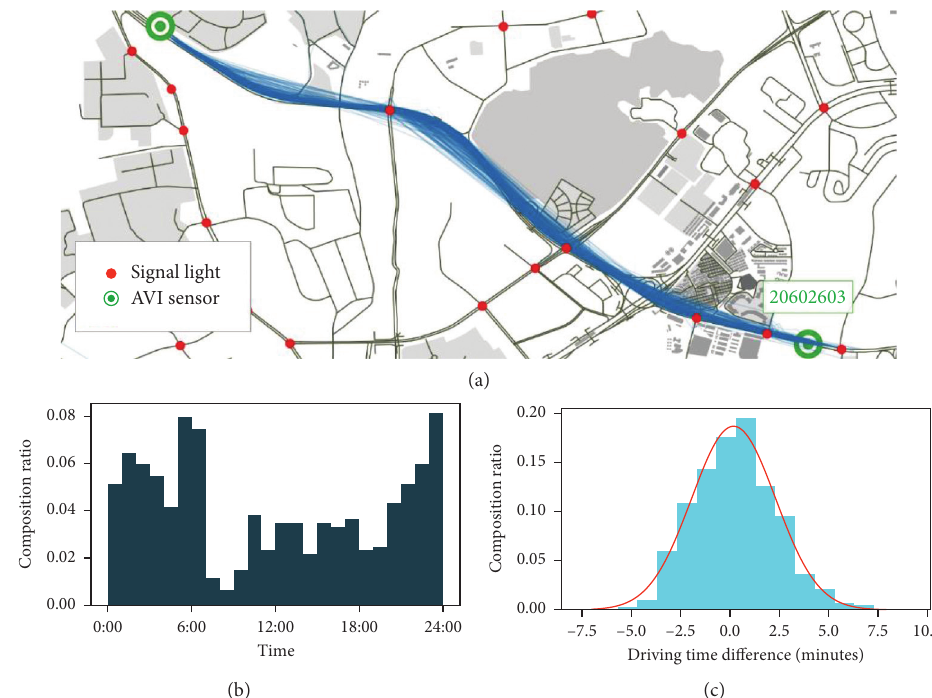
Figure 5: (a) GPS trajectories of samples. (b) Temporal distribution of the samples. (c) Histogram of the temporal constraint between 6:00 and 7:00 (fitting result: μ � 0 . 18 and σ � 2 . 13, goodness of fit: 0.98).